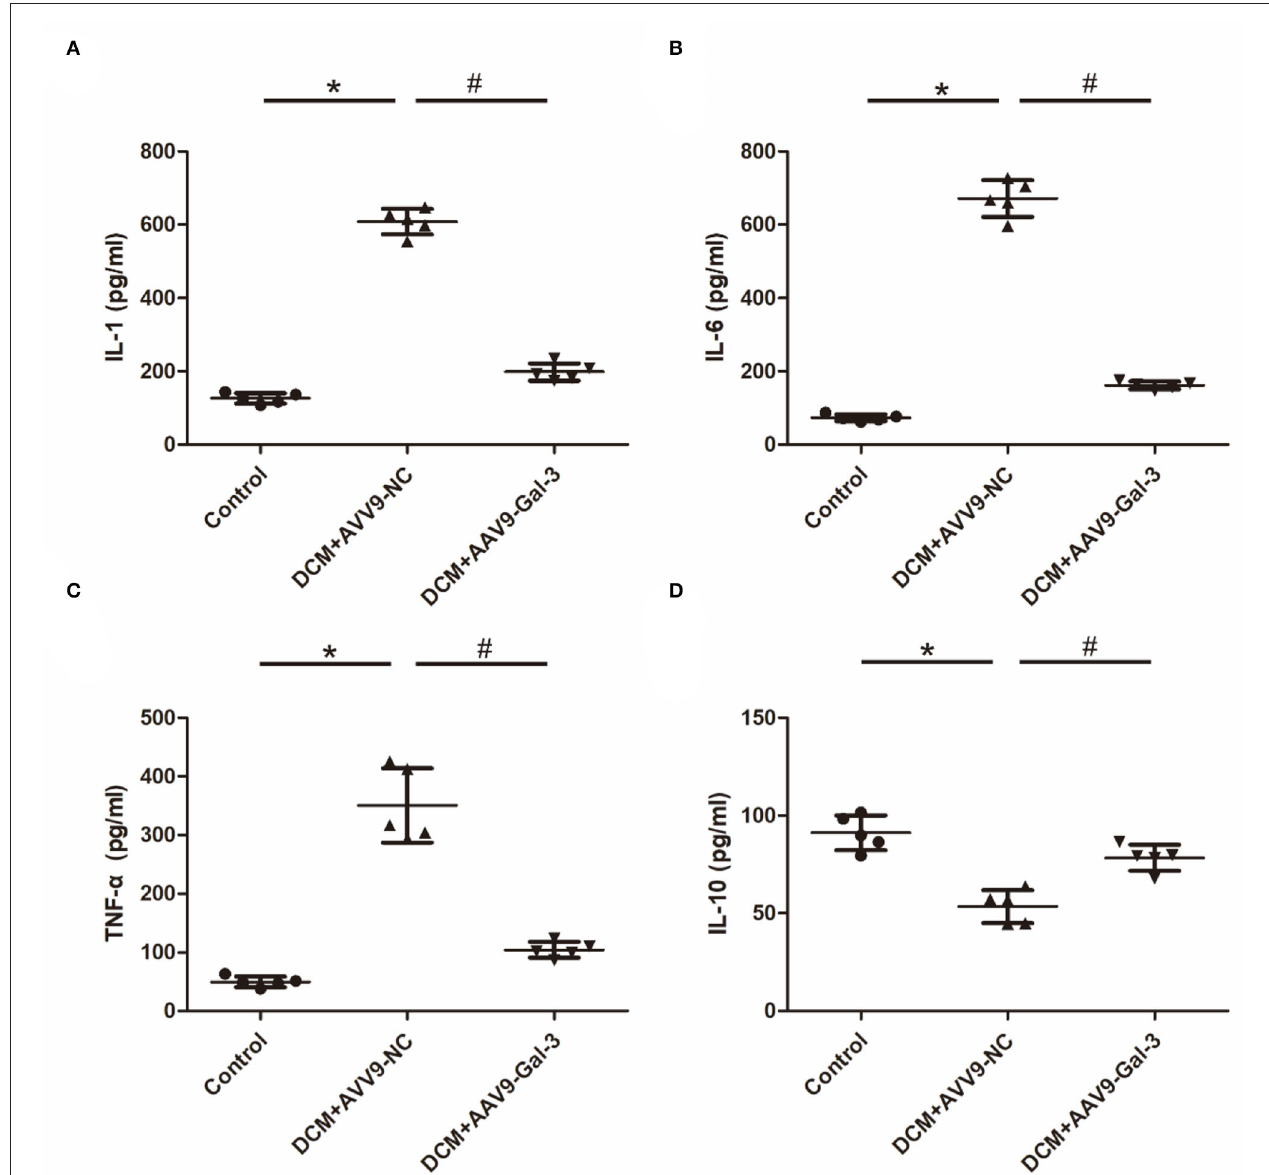
FIGURE 5 | Gal-3 inhibition modulated diabetes-induced cytokines expression (A–D) ELISA analysis of IL-1, IL-6, TNF- α and IL-10. Data are shown as mean ± SD. n = 5, * P < 0.05 vs. Control; # P < 0.05 vs. DCM +